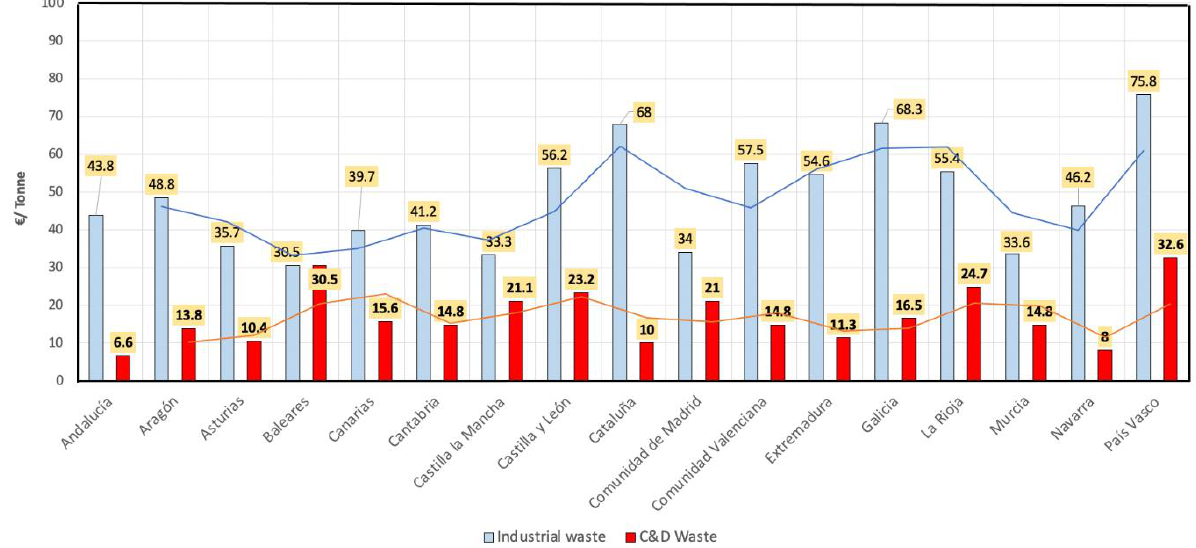
Figure 3. Comparison of disposal costs for industrial and C & D waste of Spanish autonomous communities. Source: own elaboration with data collected from [33].